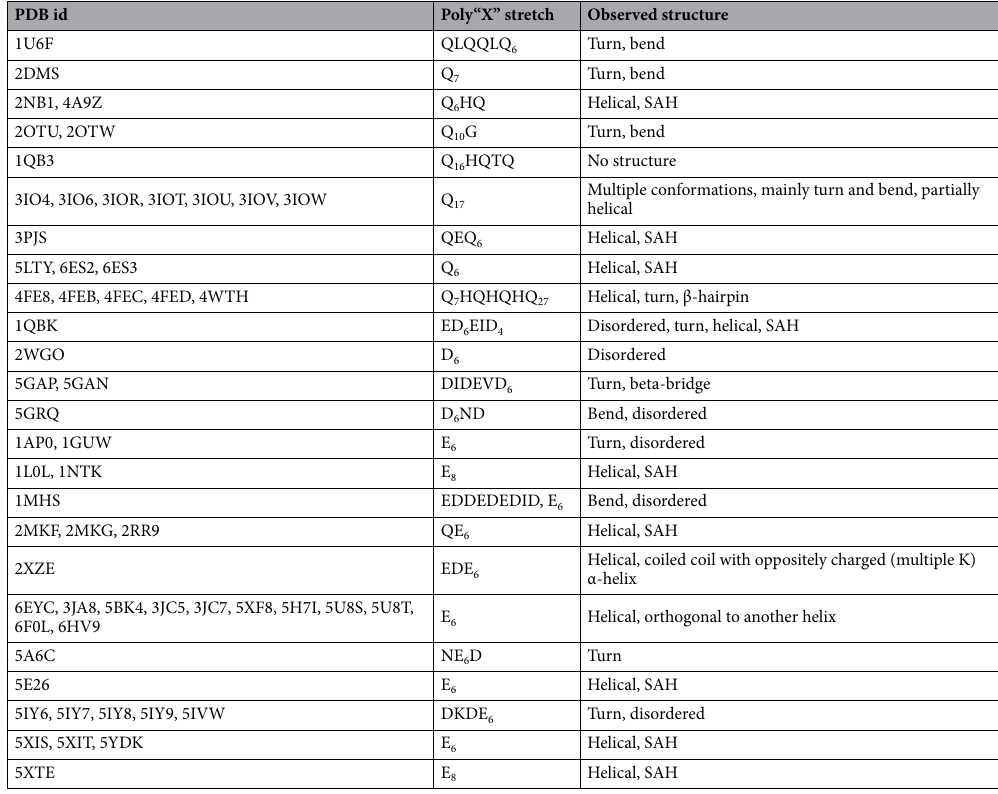
Table 1. Crystal structures of proteins containing stretches of at least six glutamines, aspartates or